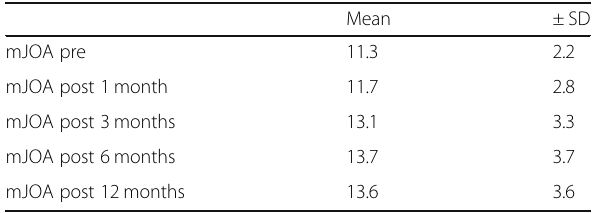
Table 2 Comparison between preoperative and postoperative mJOA score mean values at different follow-up intervals among PL group